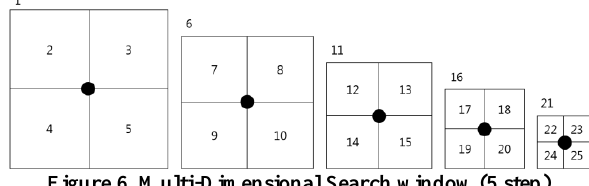
Figure 6. Multi-Dimensional Search window (5 step)